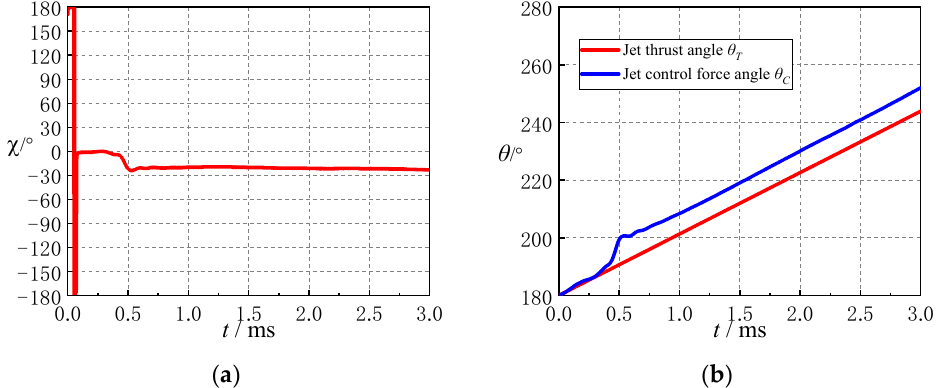
Figure 13. Variations of jet interference force deflection angle, jet thrust angle and jet control force angle with time since lateral jet startup: ( a ) Deflection angle of the jet interference force; ( b ) θ T and θ C .